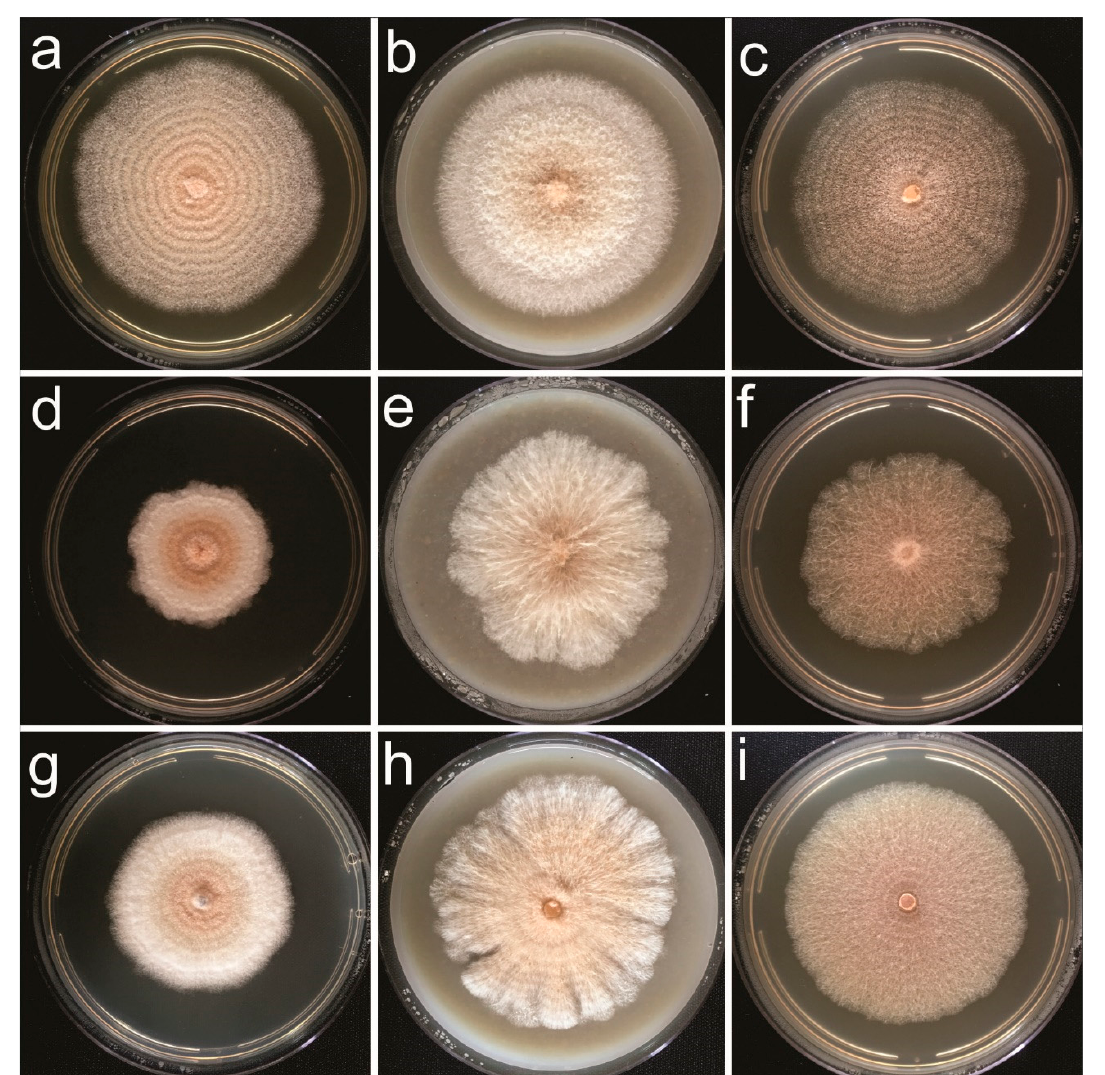
Figure 3. Ten-day-old colonies of Clonostachys spp. grown in a 25 °C 12/12 h daily light/dark regime. Left to right, PDA − OA − MEA media: ( a – c ) C. byssicola COAD 2983 ( d – f ) C. rhizophaga COAD 2979 and ( g – i ) C. rosea f. rosea COAD 2985.